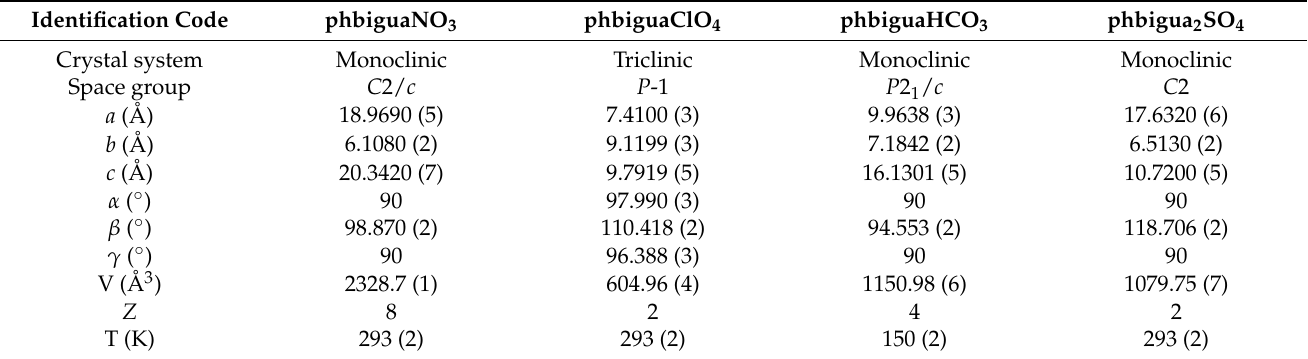
Table 1. Basic crystallographic data of phbiguaNO 3 , phbiguaClO 4 , phbiguaHCO 3 , and phbigua 2 SO 4 .